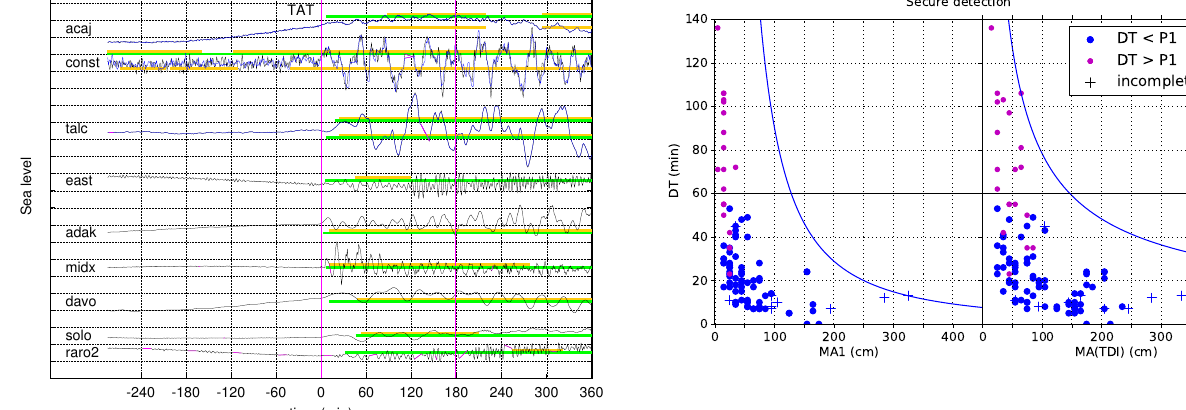
Fig. 8. Delay time DT of the secure-detection alerts vs. the max- imum amplitude of the first tsunami wave MA1 (left) and of the tsunami within the TDI window MA(TDI) (right). Complete and in- complete records (affected by data gaps or magnitude saturation and marked with an asterisk in Table 1) are depicted distinctly. A gross estimate of the parameters envelope results in the following values a=1 . 79 10 5 , b=1.65 for the graph of DT vs. MA1 and a=1 . 96 10 3 , b=0.70 for the graph of DT vs. MA(TDI) that are displayed in Fig. 9, where DT is measured in minutes and MA1 and MA(TDI) in